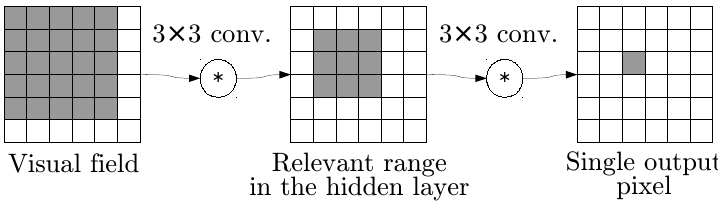
Figure 3. Each output pixel depends on multiple elements from the previous layers. The scope of the related pixel from the previous convolutional layer matches the size of the convolutional filter applied. By tracking the dependencies back to the input data matrix, we can determine the size of the visual (receptive) field. The convolutions involve one-pixel padding from each side, so the image size does not change. A single output pixel is calculated on the basis of 3 × 3 minor of the hidden layer, and the size of the visual field is 5 ×